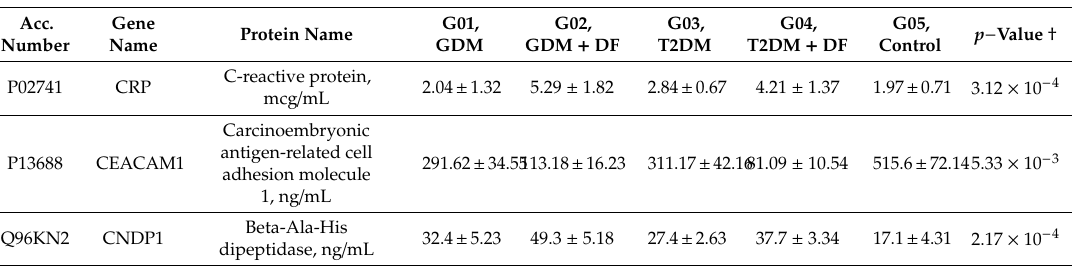
Table 3. Measured concentrations of CRP, CNDP1 and CEAEAM1 in groups with T2DM and GDM patients. Alternating concentrations probably does not permit to distinguish types of diabetes mellitus but allow proper recognition of groups with associated fetus development complication in form of diabetic